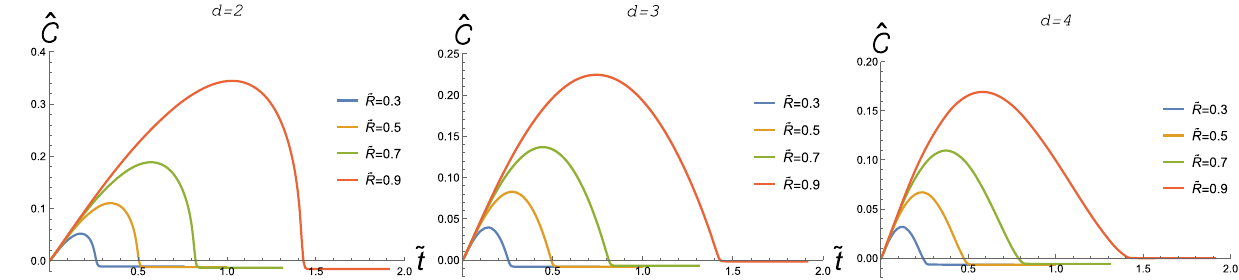
Fig. 1 Time evolution of normalised HSCV density ˆ C for various ˜ R with fixed d . The mass is fixed as M = 1